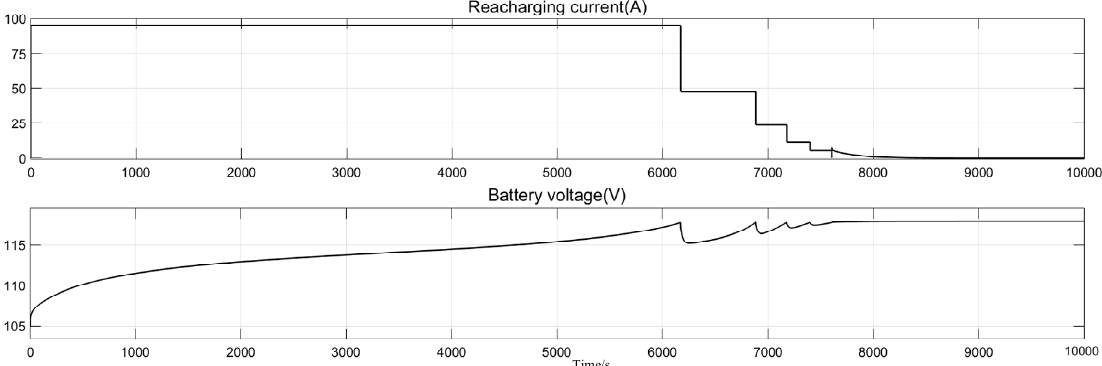
Figure 16. Pack charging simulation results.